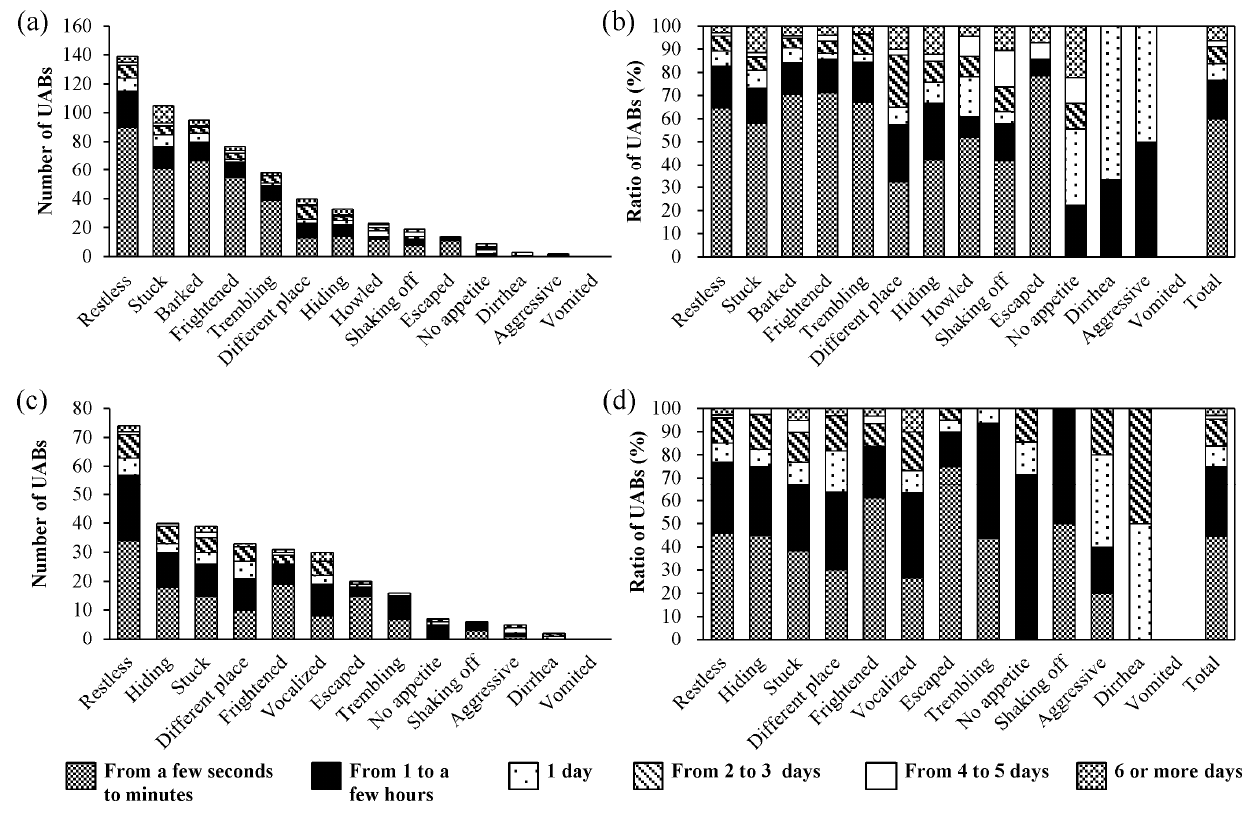
Figure 2. ( a ) Numbers of unusual animal behaviors (UABs) of dogs in each behavioral category and the time of occurrence prior to the 2011 earthquake off the Pacific coast of Tohoku, Japan; ( b ) Relative ratio normalized as % of the total; ( c ) Numbers of unusual animal behaviors (UABs) of cats in each behavioral category and the time of occurrence prior to the 2011 earthquake off the Pacific coast of Tohoku, Japan; ( d ) Relative ratio normalized as % of the total.